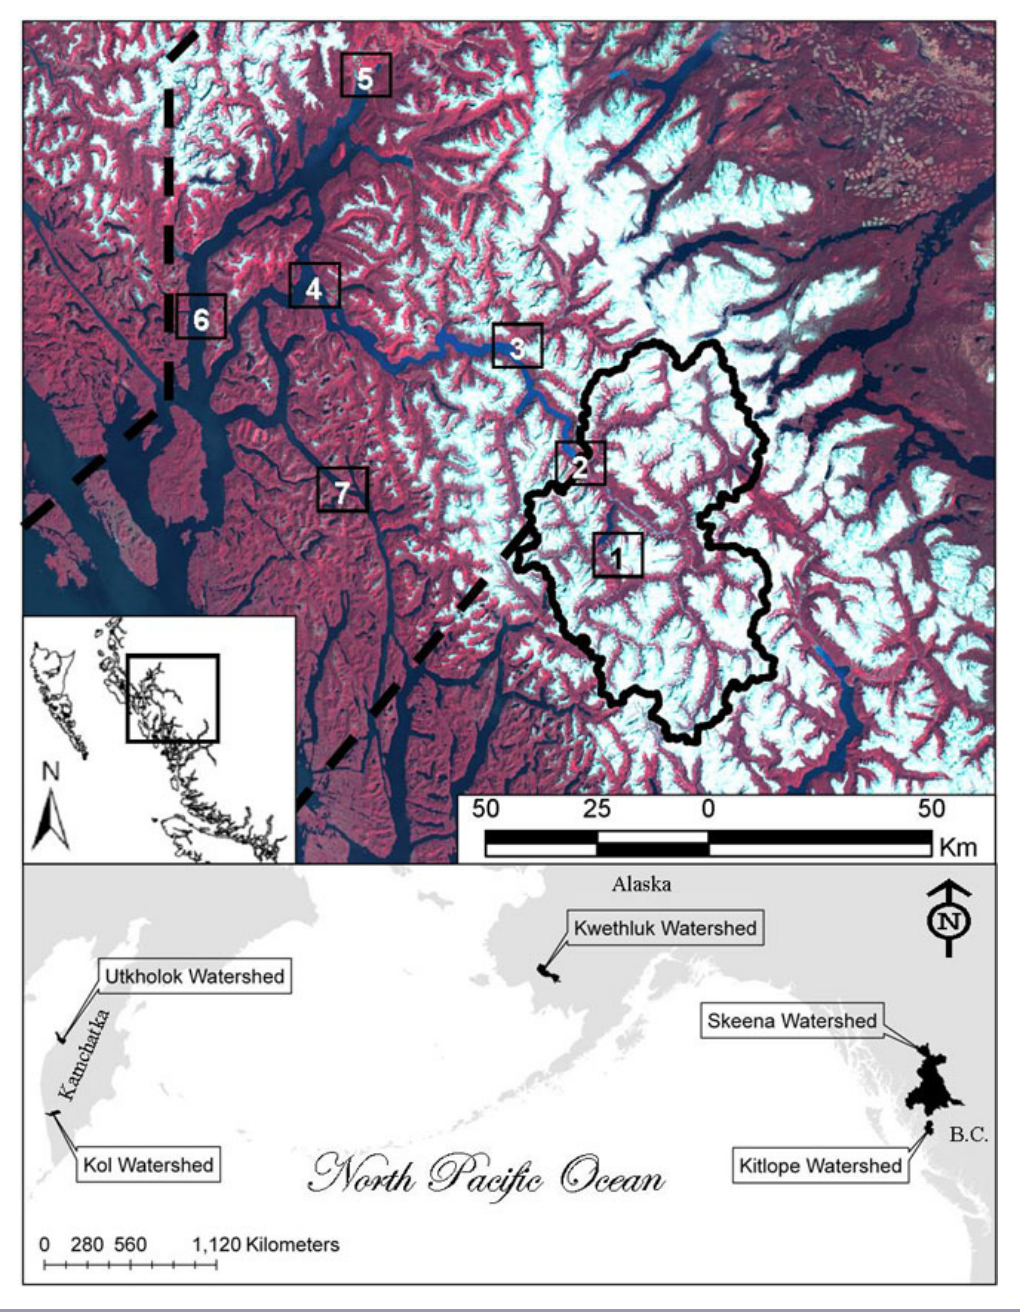
Fig. 1 . Location map with top portion showing the 3200 km 2 Kitlope drainage basin and protected area boundary (solid black line) and (1) Kitlope Lake, (2) Kitlope River mouth/estuary, (3) Kemano River estuary and village site, (4) entrance to Gardner Canal, (5) Kitimat River estuary and hatchery, (6) Douglas Channel, and (7) former Butedale cannery site. The dashed line demarks the marine boundaries of federal fisheries Management Area